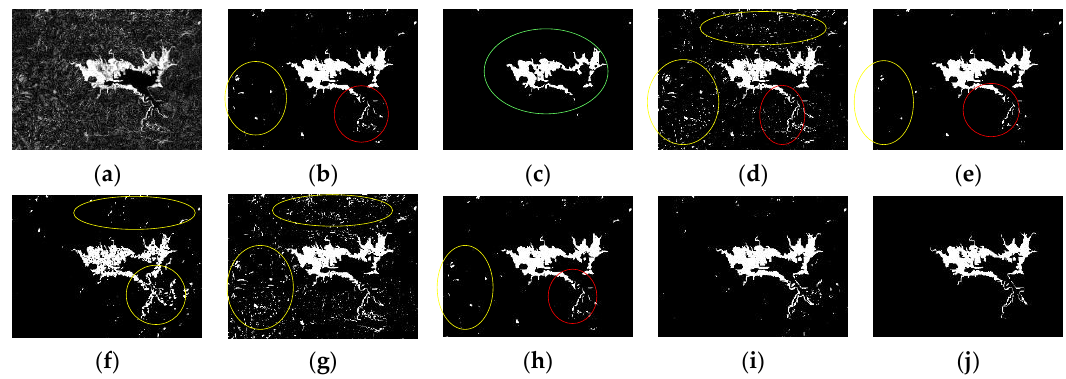
Figure 9. Results of the Sardinia dataset. ( a ) Difference image. ( b ) KI. ( c ) MRF+EM. ( d ) FCM. ( e ) FLICM. ( f ) GA-mask. ( g ) GA-FCM. ( h ) MOEA/D. ( i ) Proposed M-DECD. ( j ) Reference map.